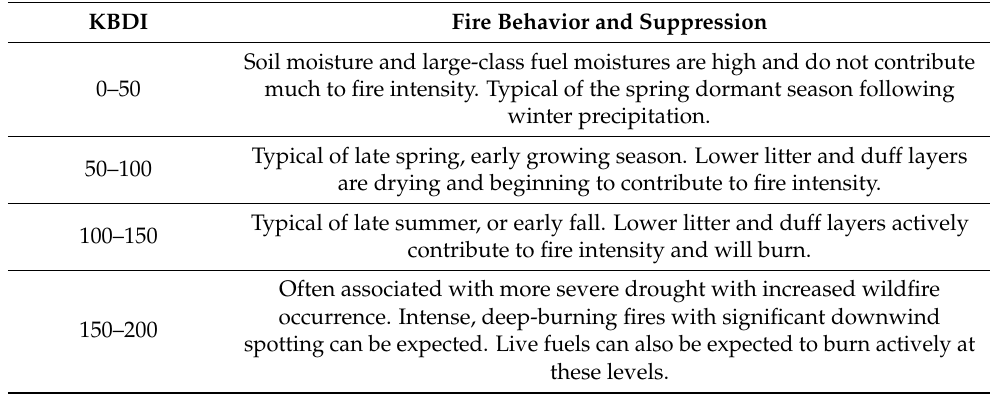
Table 4. Keetch—Byram drought index (KBDI) scale and interpretation (adapted from the traditional U.S. Forest Service interpretation of the Keetch–Byram drought index